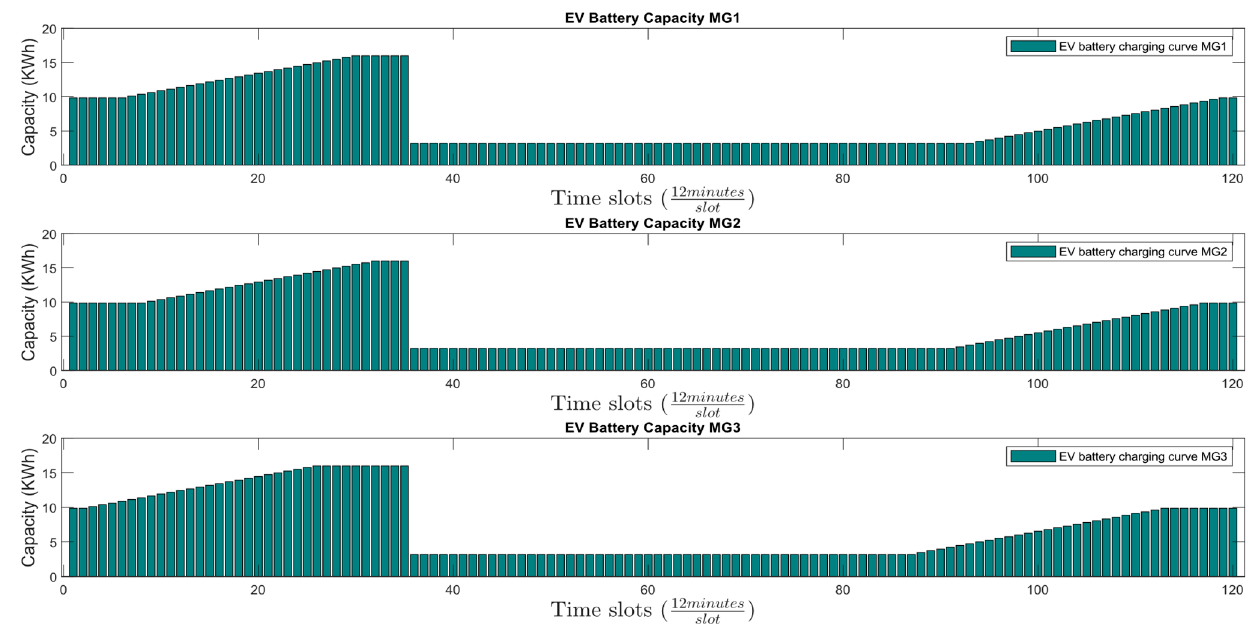
Figure 15. Per-slot load comparison for scheduled and unscheduled load.